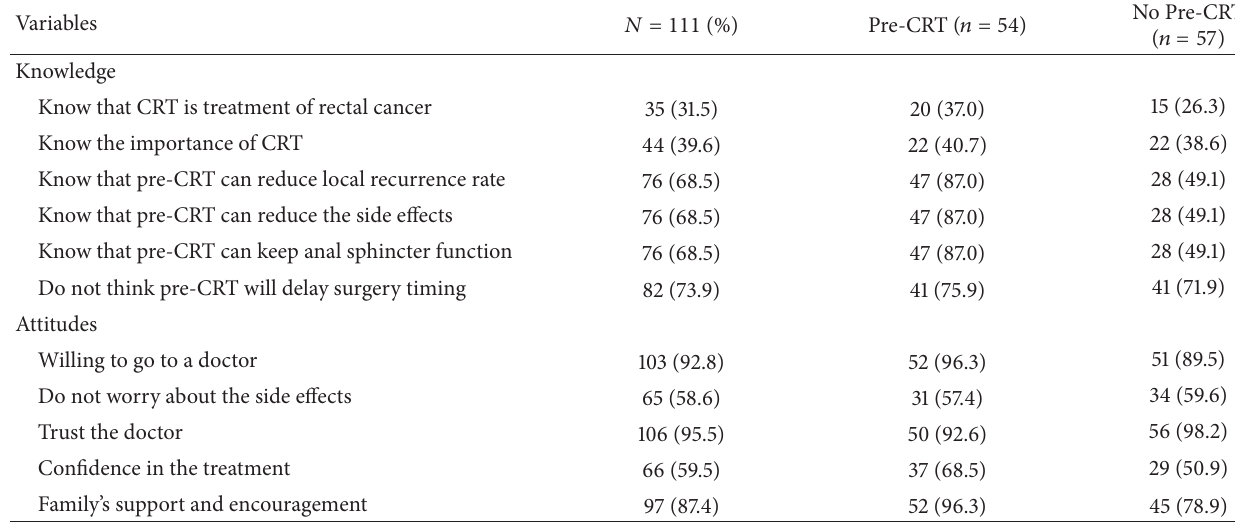
Table 2: Knowledge, attitudes, and practices of rectal cancer